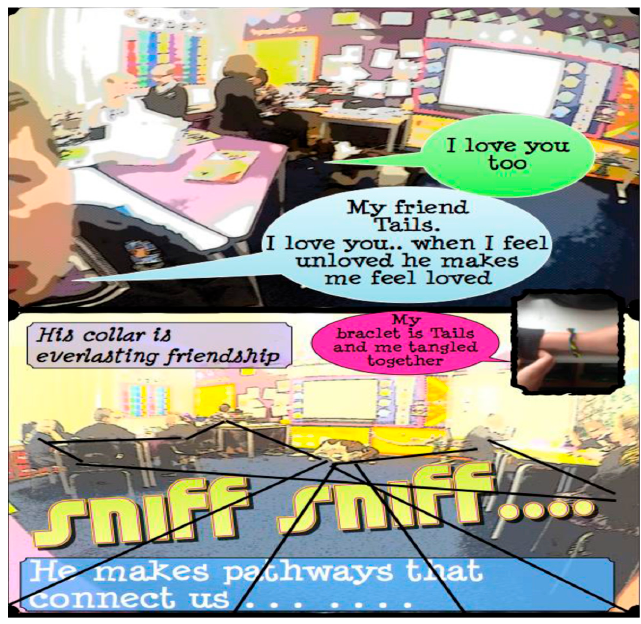
Figure 4. Example of comic panels showing “...he (Ted) makes pathways that bring us